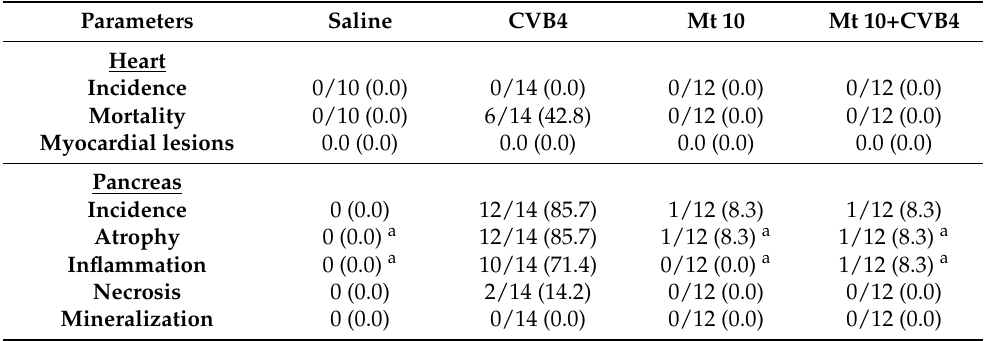
Table 1. Histological evaluation of hearts and pancreata in saline, CVB4, Mt 10-vaccinated, and Mt 10-vaccinated and challenged